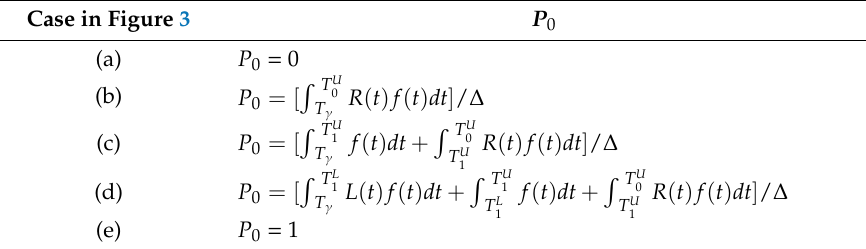
Figure 3. Five different types of membership functions of T for the right-sided test. Table 1. The possibility P 0 for the right-sided test.